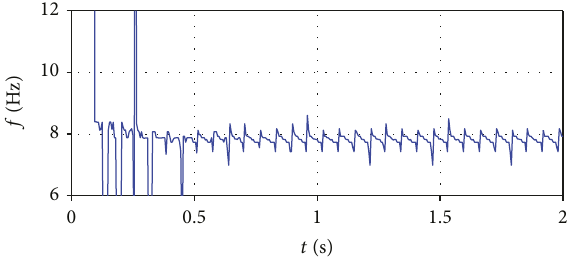
Figure 38: D5, decay test CWT, acceleration in the damaged node. Figure 39: D2, 20Hz excitation 1st superharmonic, full